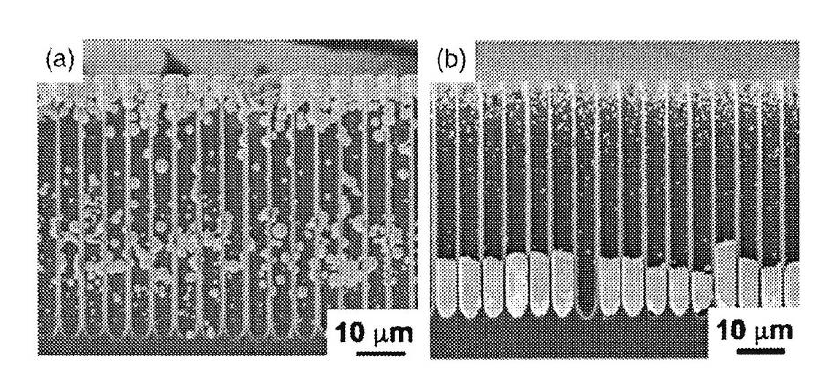
Figure 16. SEM micrographs of cross sectional regions of metal filled macroporous silicon. (a) Pt deposition within p-type macroporous silicon forming particles within the pores. As supporting electrolyte Na SO is used. (b) Pt deposition into the pores in using 2 4 NaCl as supporting electrolyte resulting in metal-rods. (Reproduced by permission of The Electrochemical Society